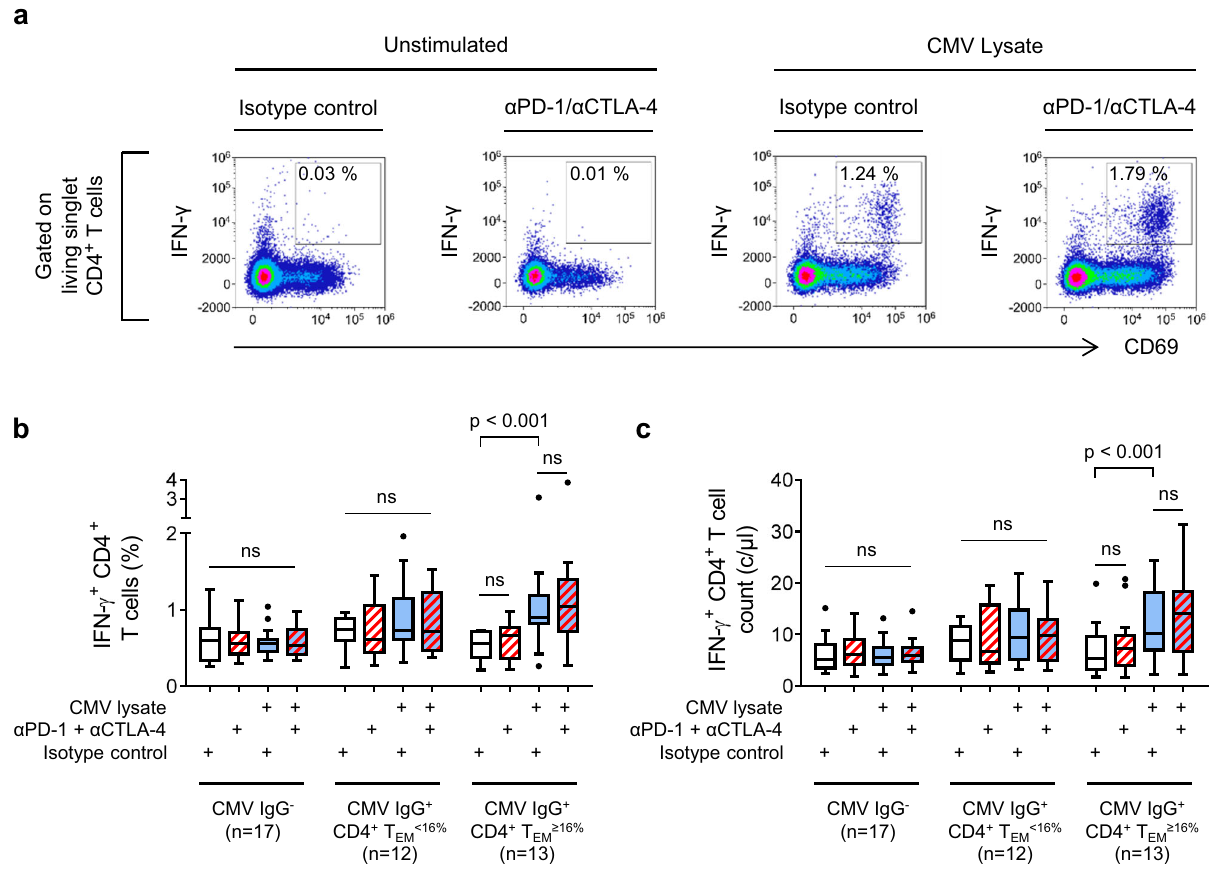
Fig. 6 CMV-reactive CD4 + T cells are enriched in patients with CD4 + T EM cell expansion. CMV-reactive CD4 + T cells in patients with unresectable metastatic melanoma were assayed by in vitro stimulation with CMV lysates (blue boxes). Neutralising antibodies (red hatching) were used to detect T cells unable to respond to CMV antigens owing to expression of PD-1 or CTLA-4. T cell responses were quanti fi ed by fl ow cytometry analysis of cytokine expression. a Example data from a CMV IgG + CD4 + T EM ≥ 16% patient who developed hepatitis. Gating of live, singlet, IFN- γ -producing CD4 + T cells is illustrated in Supplementary Fig. 11. b Frequencies of IFN- γ -producing CD4 + T cells in patients categorised according to CMV IgG serostatus and baseline CD4 + T EM frequency ( n = 42; two-way ANOVA with Tukey correction for multiple comparisons; n.s. = not signi fi cant). Boxplots represent the median, 25th and 75th percentiles, and Tukey whiskers. c Absolute numbers of circulating IFN- γ -producing CD4 + T cells patients categorised according to CMV IgG serostatus and baseline CD4 + T EM frequency ( n = 42; two-way ANOVA with Tukey correction for multiple comparisons; n.s. = not signi fi cant). Boxplots represent the median, 25th and 75th percentiles, and Tukey